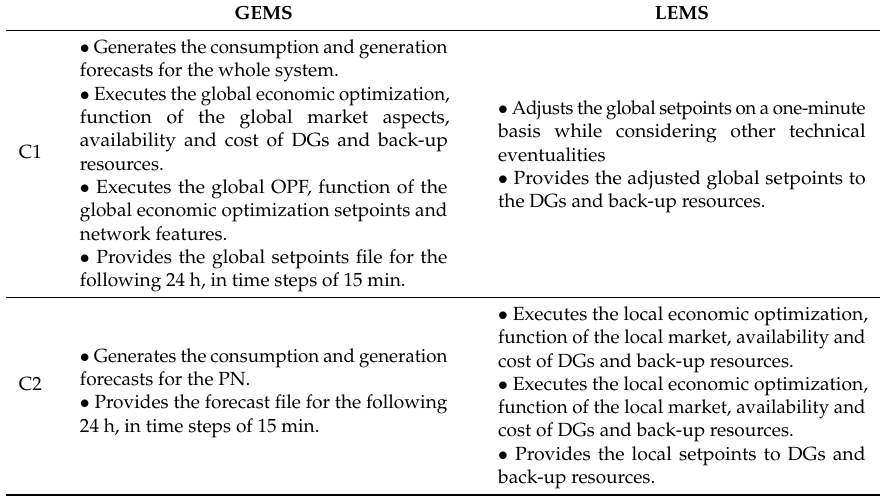
Table 4. Roles of Global Energy Management System (GEMS) and Local Energy Management System (LEMS) depending on the operational